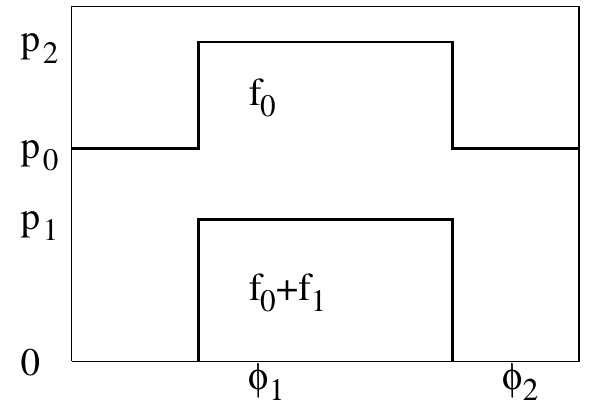
FIG. 2. Wall current monitor data for a freshly injected bunch.